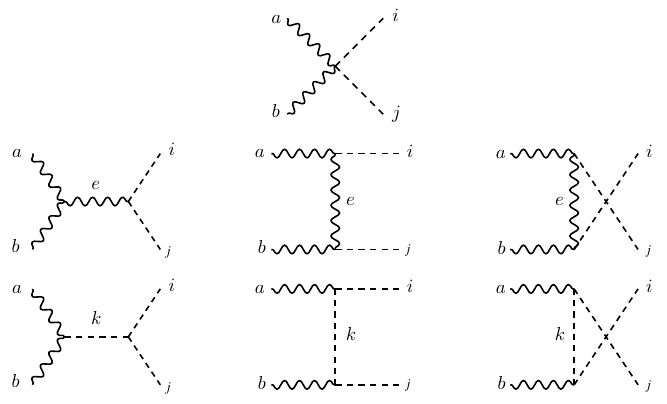
Figure 3 . Amplitudes for the scattering A a A b ! (cid:30) i (cid:30) j